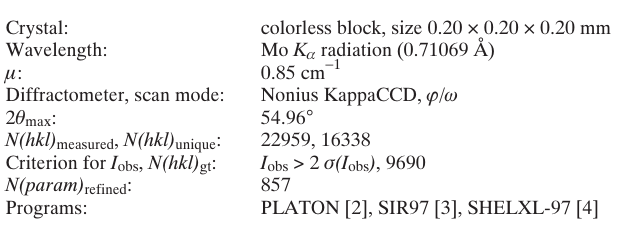
Table 1. Datacollection and